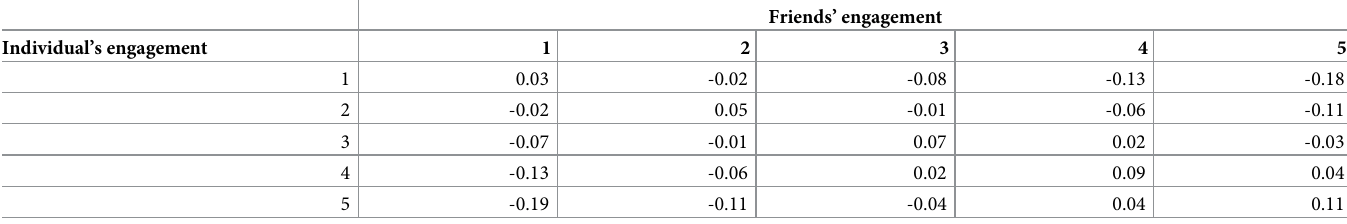
Table 4. Ego-alter selection: Selection of friends (alters) on adolescents’ (egos’)